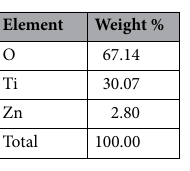
Table 2. Percentage of elements in T2 ‒ Z1/CS.